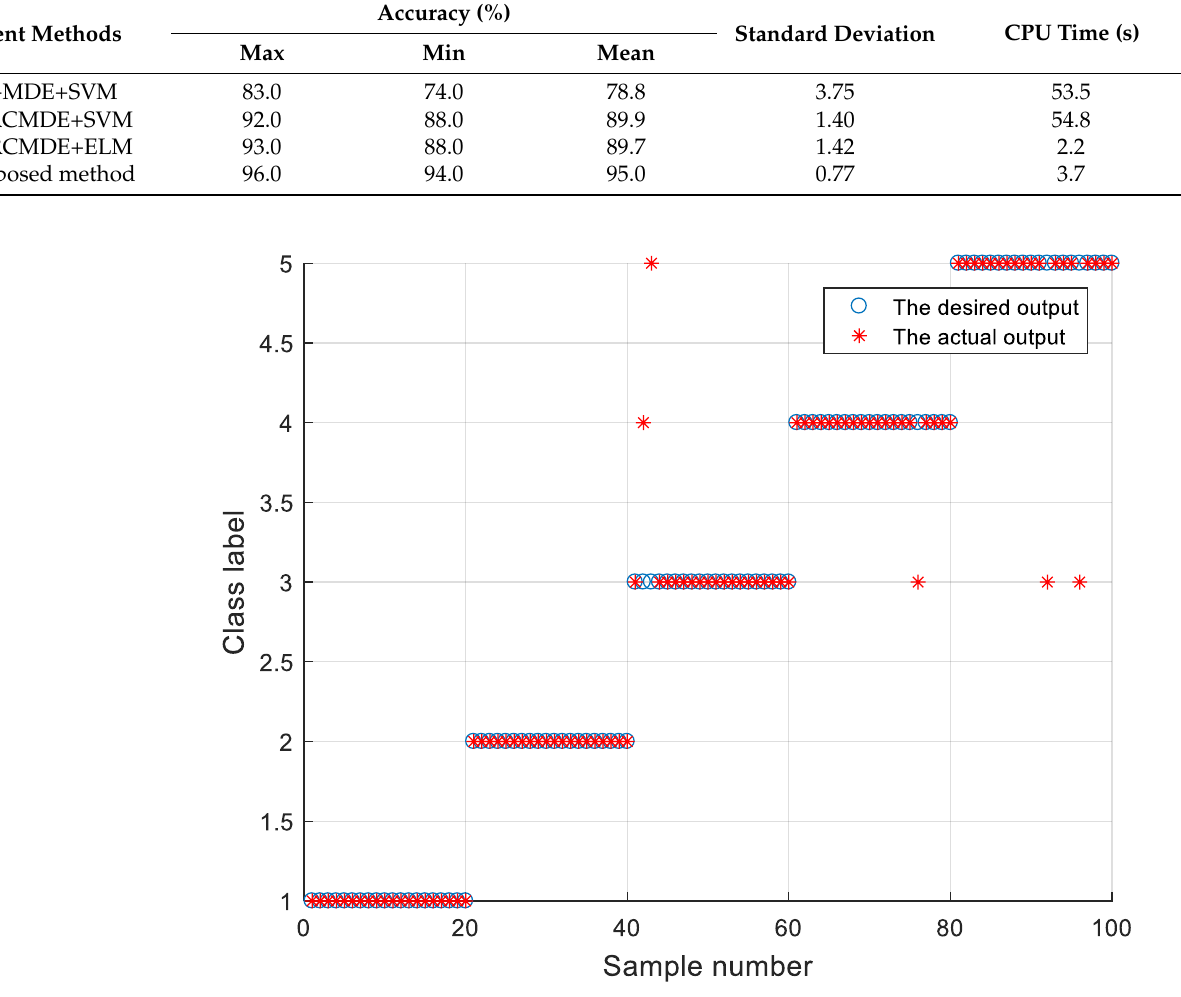
Figure 11. Classification results of the data collected by the WTDS.